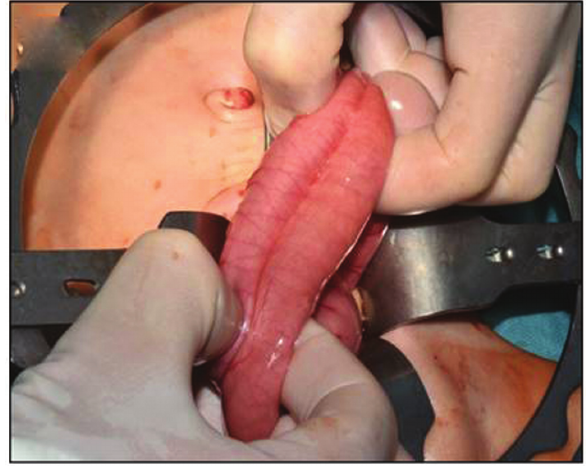
Fig. 3 Completely duplicated colon with a septum and common